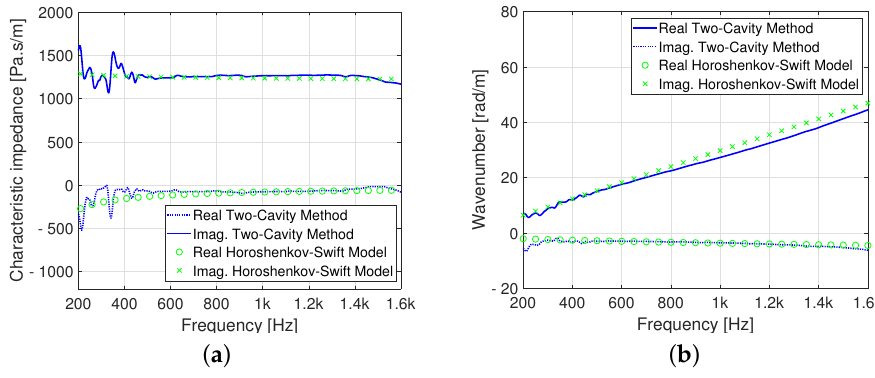
Figure 8. Comparison between the experimental characterisation and the semi-phenomenological representation n . ( a ) Characteristic impedance, ˜ Z c . ( b ) Wave number, ˜ k c (retrieved from